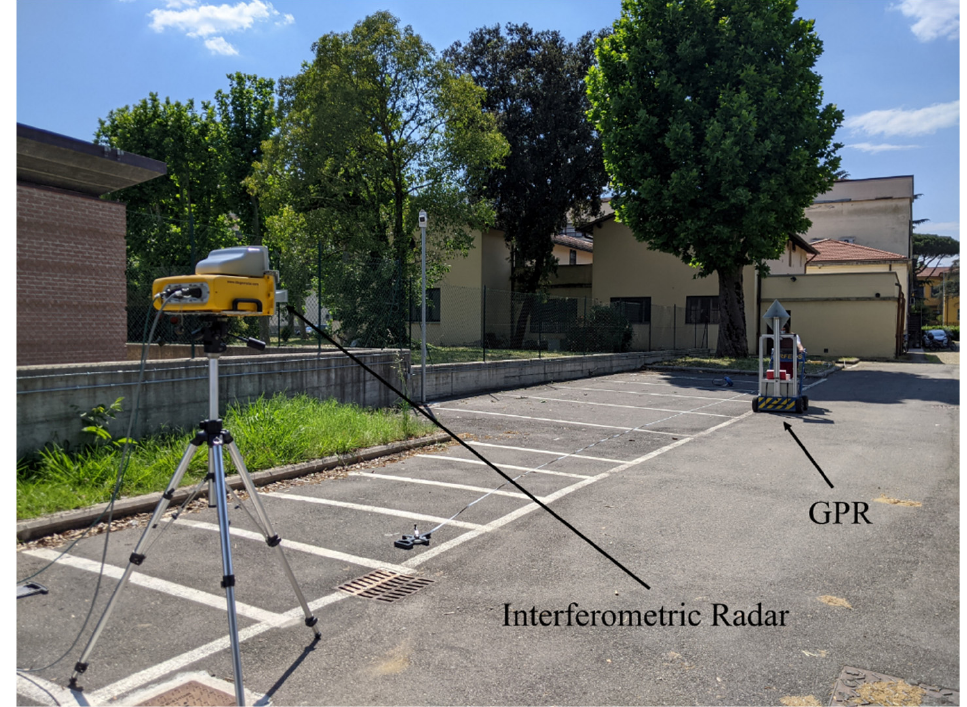
Figure 8. Experimental setup for GPR positioning by interferometric radar.